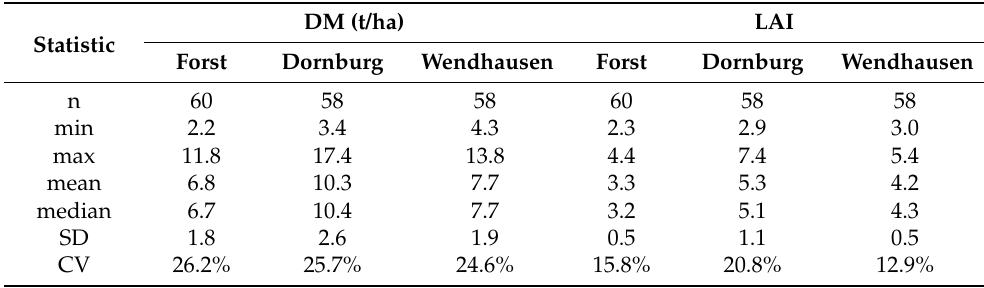
Table 2. Descriptive statistics for DM and LAI values measured at subplots (SD = standard deviation, CV = coefficient of variation).